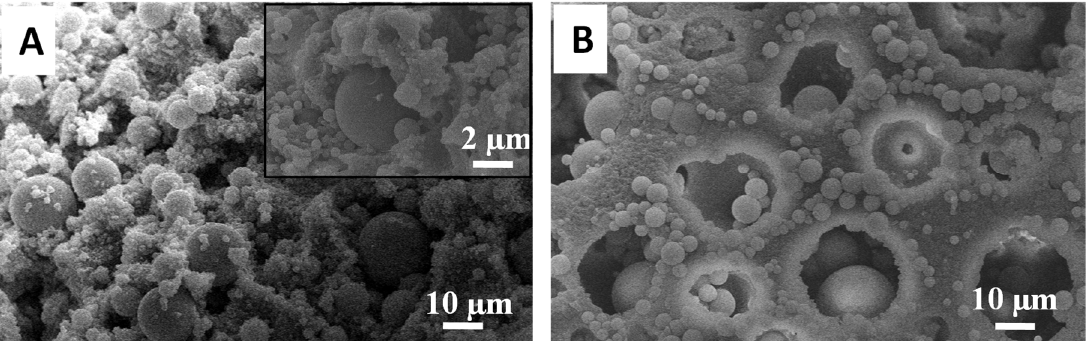
Figure 4. Silica microspheres were synthesised inside PAM beads by employing both TEOS and MPTMS in the reaction. ( A ) Cross-sectioned surface of the as-prepared bead with the inset showing the silica spheres on the pore surface. ( B ) Exterior surface of the as-prepared bead showing a distribution of large microspheres trapped within the macropores.